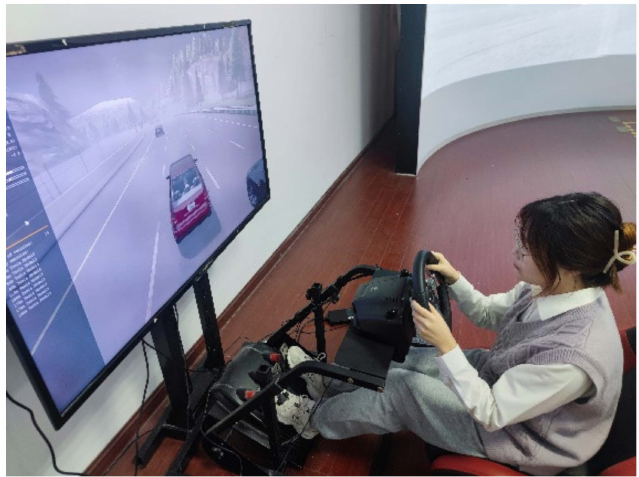
Figure 1. Driving simulation